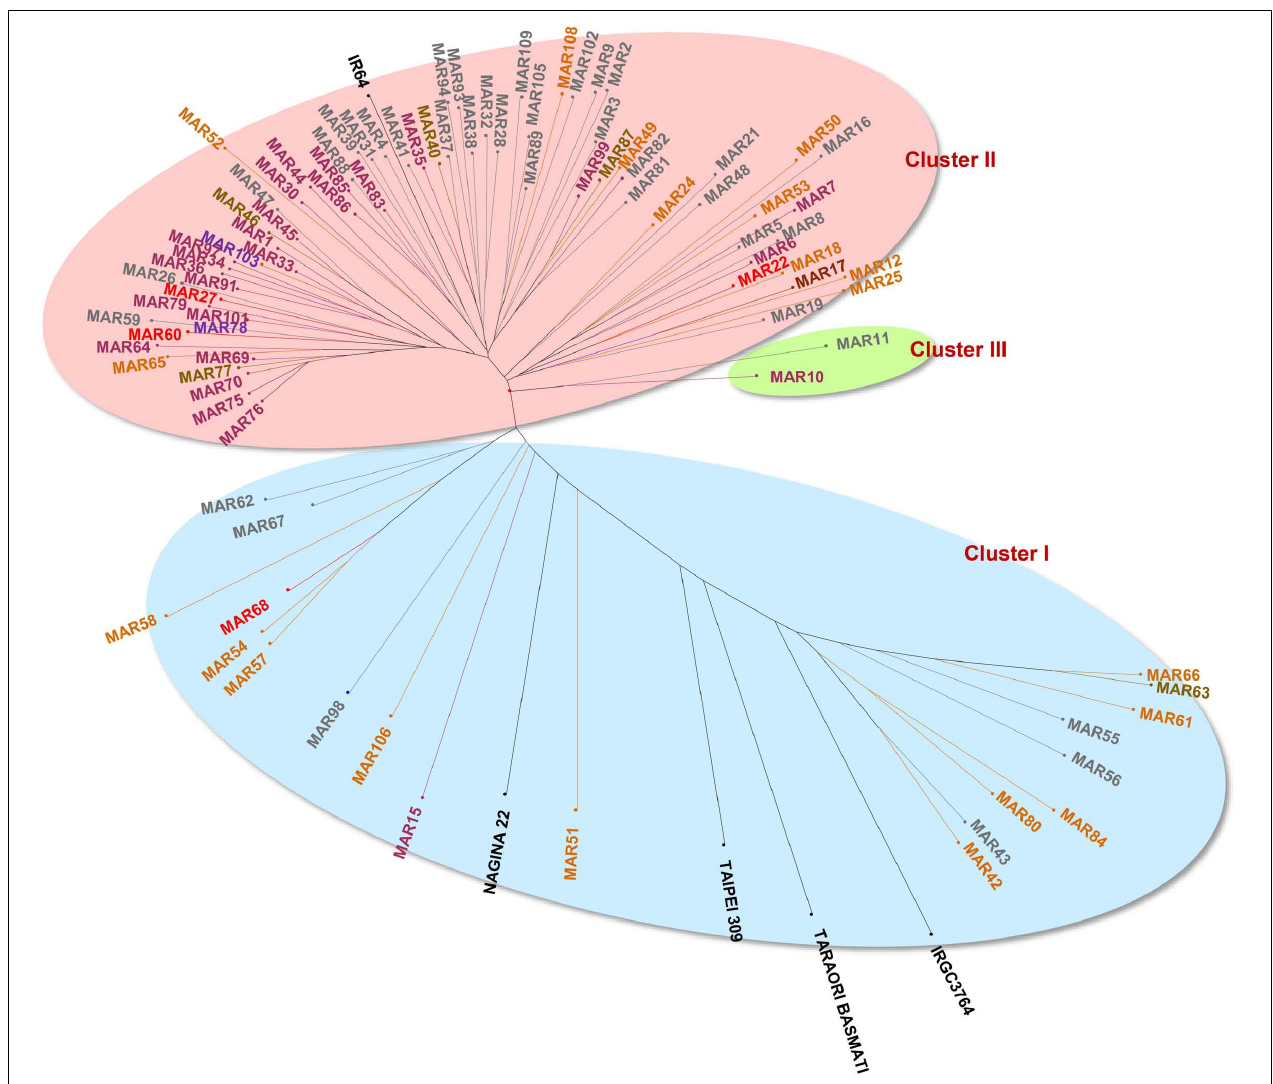
FIGURE 6 | Hierarchical clustering of aromatic rice genotypes from Manipur based on SSR markers by unweighted neighbor joining using simple matching coefficients showing three distinct